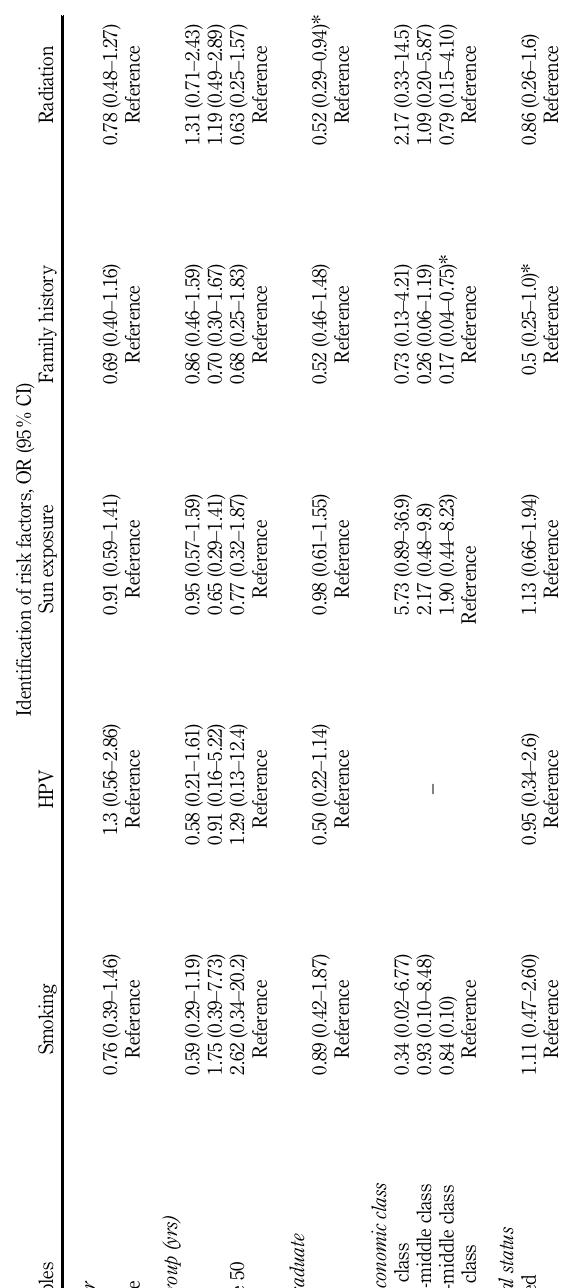
Table 3. Identification of risk factors of head and neck cancer by sociodemographic